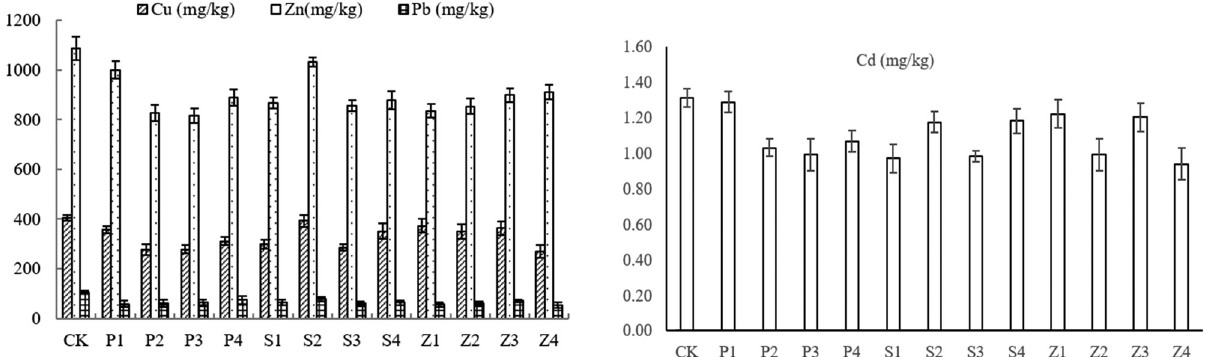
Figure 1: Changes in dissolved heavy metal content in di ff erent treatments. Note: The treatments in the fi gure are CK - control without passivation agent, P1 - palygorskite 1%, P2 - palygorskite 2%, P3 - palygorskite 3%, P4 - palygorskite 5%, S1 - sepiolite 1%, S2 - Sepiolite 2%, S3 - Sepiolite 3%, S4 - Sepiolite 5%, Z1 - Zeolite 1%, Z2 - Zeolite 2%, Z3 - Zeolite 3%, and Z4 - Zeolite